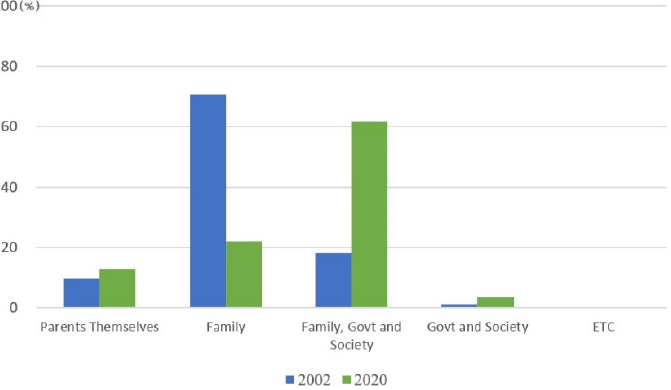
Figure 8. Views on parental support responsibility (2002, 2020). Note: respondents were aged over 15. Source: Korea Statistics [34,35].